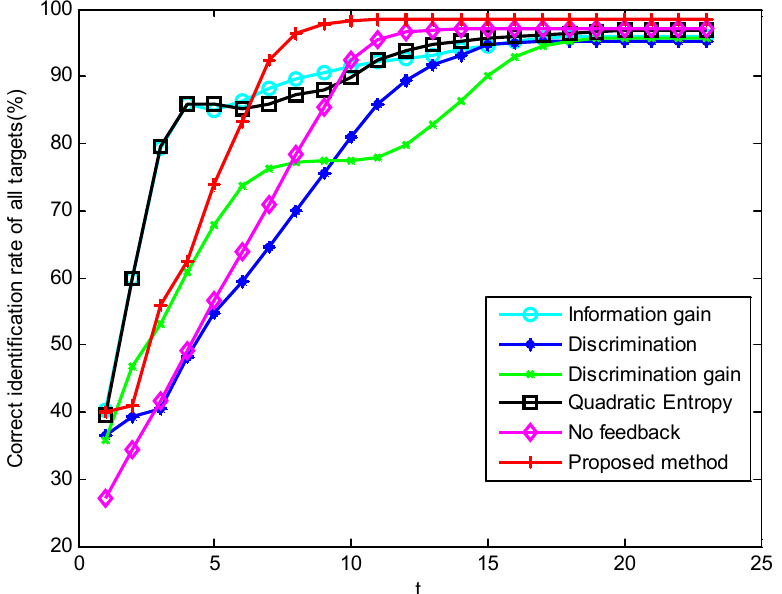
Figure 9. Sequence diagram of all target recognition accuracy rates in scenario 5 under condition 1.